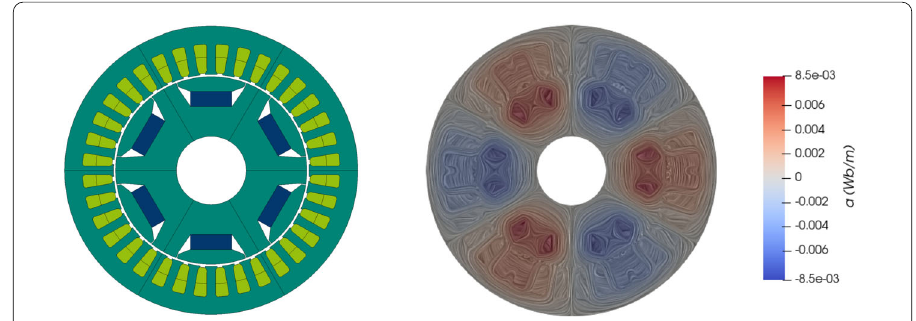
Figure 2 Left: Model of a six-pole permanent magnet synchronous machine. The rotor on the inside consists of iron (green) and permanent magnets (blue). The stator on the outside consists of iron (green) and the slots for the copper windings (light green). Right: Magnetic vector potential a and magnetic field lines in the